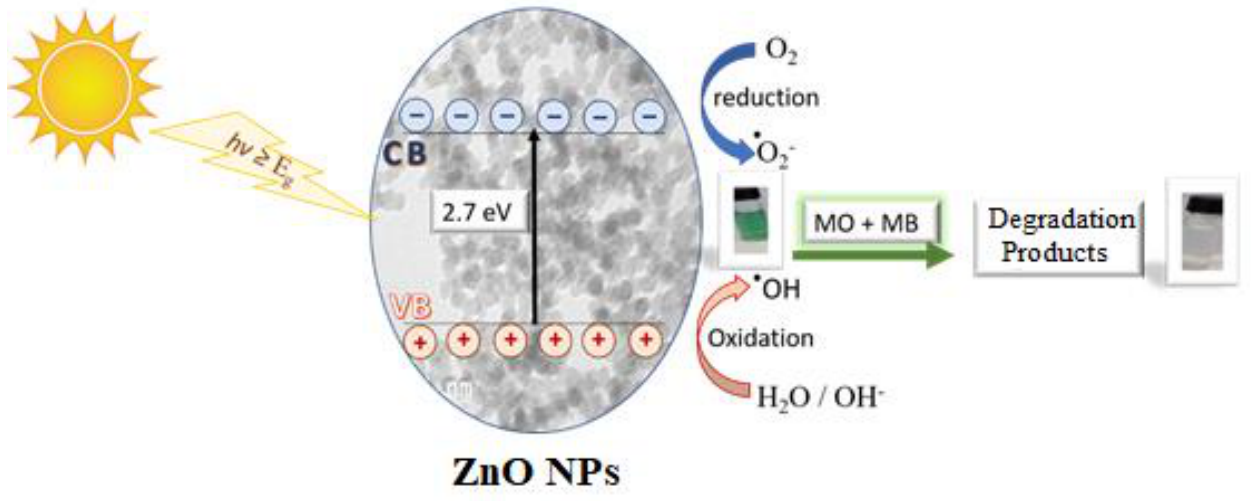
Figure 10. The proposed mechanism for the photo-degradation of MO,MB dyes by the BMW ZnO NPs.